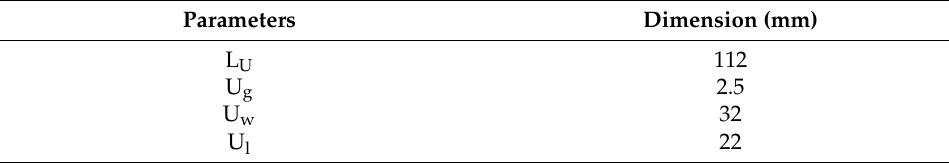
Figure 11. 3 × 3 Array Structure, Proposed 3 × 3 Array ( a , b ), Snapshot of Fabricated 3 × 3 Array. ( c , d ), ( a , c ) Front view, ( b , d ) Back view. Table 3. Parameter specifications of 3 × 3 Array periodic structure.